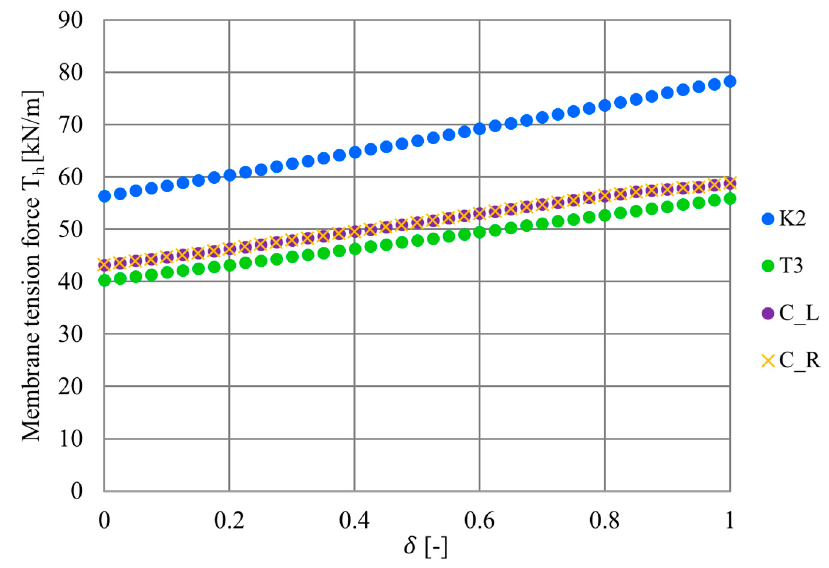
δ ( k = δ ( k = 0). Figure 9. Membrane tension force as a function of parameter